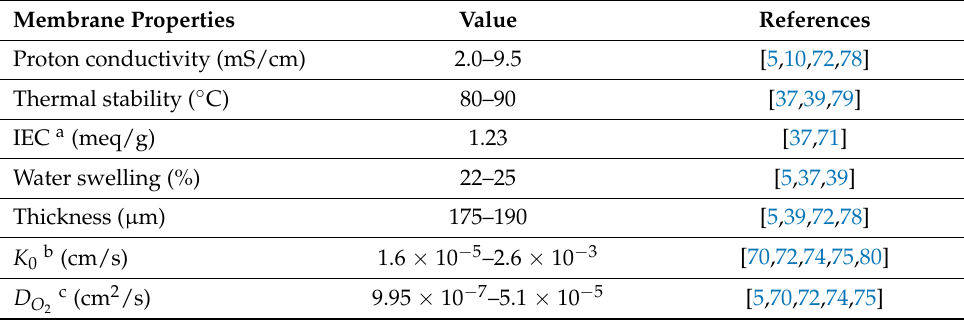
Table 1. Nafion ® 117 characteristics.